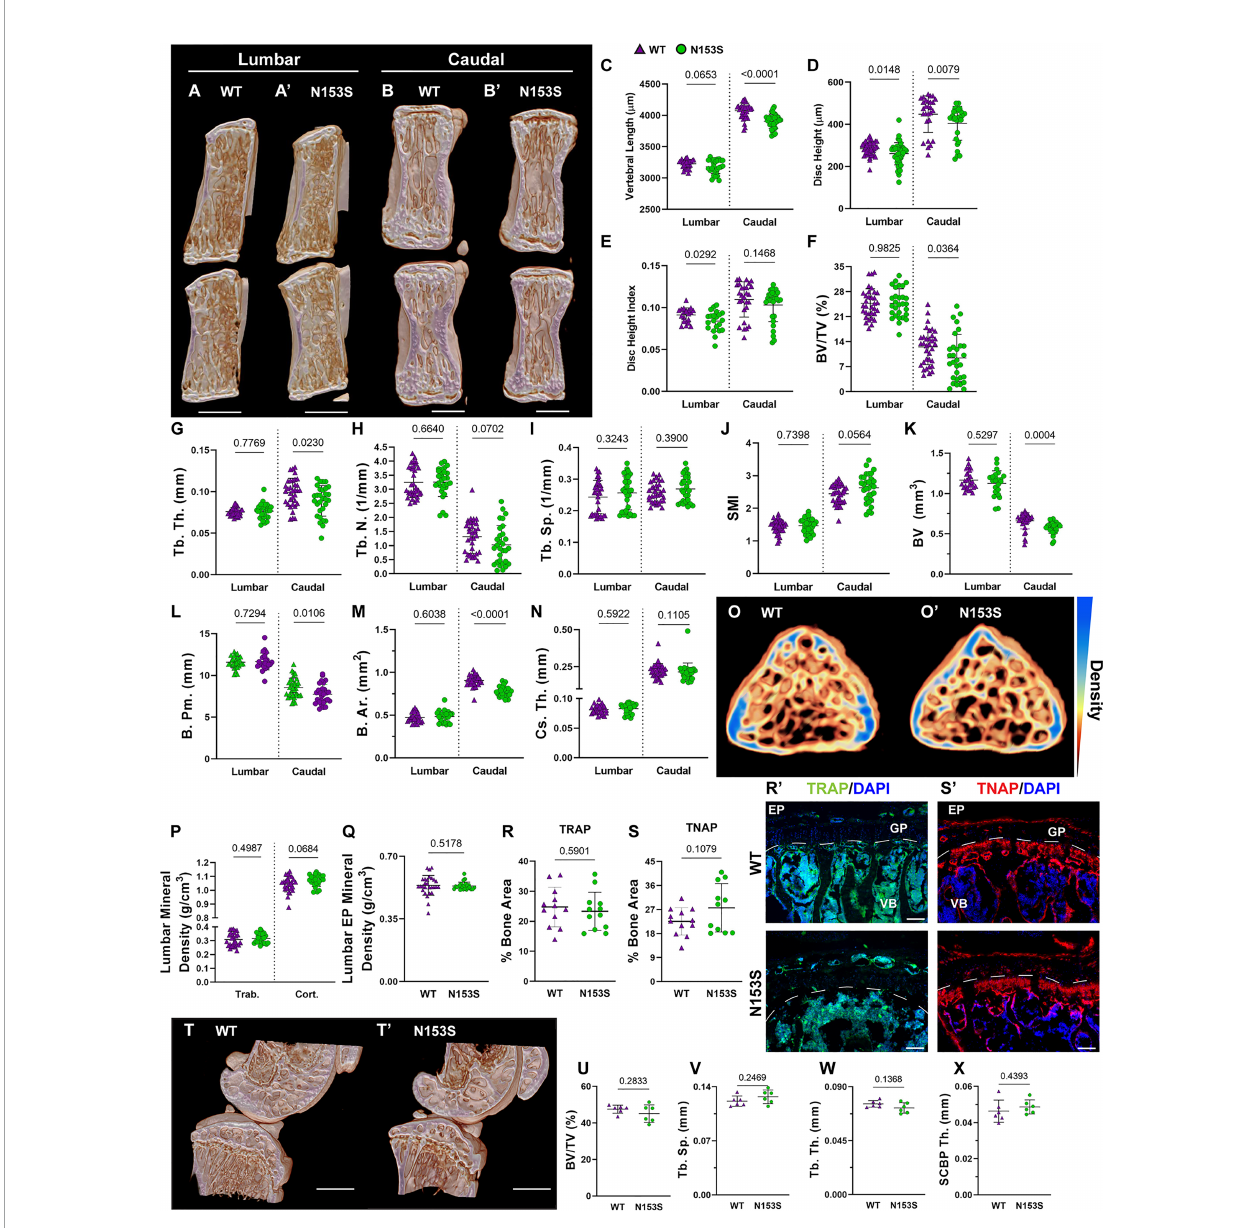
FIGURE 2 | Constitutive STING activity compromises trabecular and cortical vertebral bone properties but not knee joints. (A, B ’ ) Representative m CT reconstructions of the hemi-section of a lumbar (A, A ’ ) and caudal (B, B ’ ) motion segment in a 6-month-old WT and N153S mouse. (C) Vertebral length, (D) disc height, (E) and disc height index (DHI) are shown for lumbar and caudal vertebrae. (F, J) Trabecular bone properties of (F) BV/TV, (G) Tb. Th. (trabecular thickness), (H) Tb. N. (trabecular number), (I) Trab. Sp. (trabecular separation), and (J) SMI (structure model index) are shown for lumbar and caudal vertebrae. (K – N) Cortical bone properties of (K) BV (bone volume), (L) (B) Pm. (bone perimeter), (M) , (B) Ar. (bone area), and (N) Cs. Th. (cross- sectional thickness) are shown. (O, O ’ ) Representative cross-sections of lumbar WT and N153S vertebral bodies, with mineral density indicated on a yellow (less dense) to blue gradient (more dense). (P) Overall trabecular and cortical mineral density and (Q) boney endplate mineral density are shown. Quantitative immuno fl uorescence of (R, R ’ ) TRAP and (S, S ’ ) TNAP activity in the caudal vertebrae. Dotted lines delineate the growth plate (GP) from the rest of the vertebral body (VB). (T, T ’ ) Representative m CT reconstructions of the medial femoral condyle and tibial plateau. (U) BV/TV, (V) trabecular separation (Tb. Sp.), (W) trabecular thickness (Tb. Th.), and (X) the subchondral bone plate thickness (SCBP Th.) in the hind joints demonstrate no deviations in N153S mice. (n = 2 joints/animal, 3 animals/genotype, 6 joints/genotype) Quantitative measurements represent mean ± SD (n = 6 lumbar discs and 4 vertebrae/ mouse, 7 mice/genotype; n = 4 caudal discs and 5 vertebrae/mouse, 7 mice/genotype). (A, B ’ ) Scale bar = 1mm. (O, O ’ ) Scale bar = 250 m m. Signi fi cance was determined using an unpaired t-test or Mann-Whitney test, as